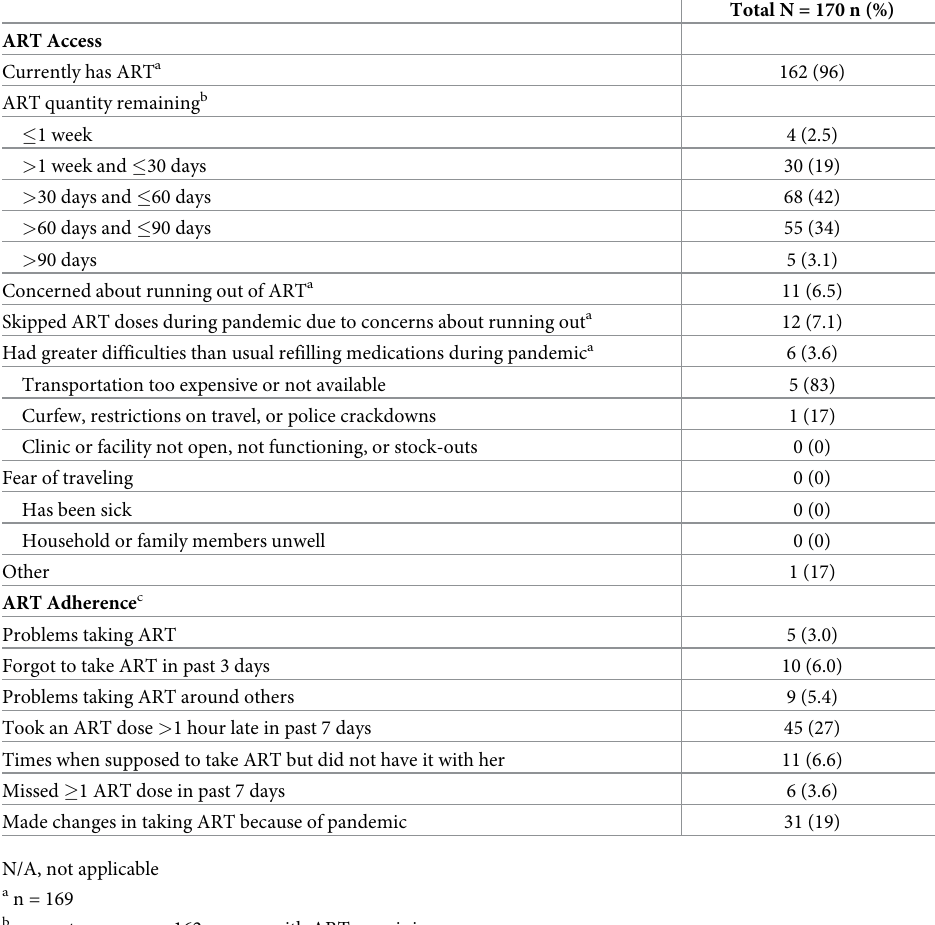
Table 4. ART access and adherence among late postpartum WHIV during the COVID-19